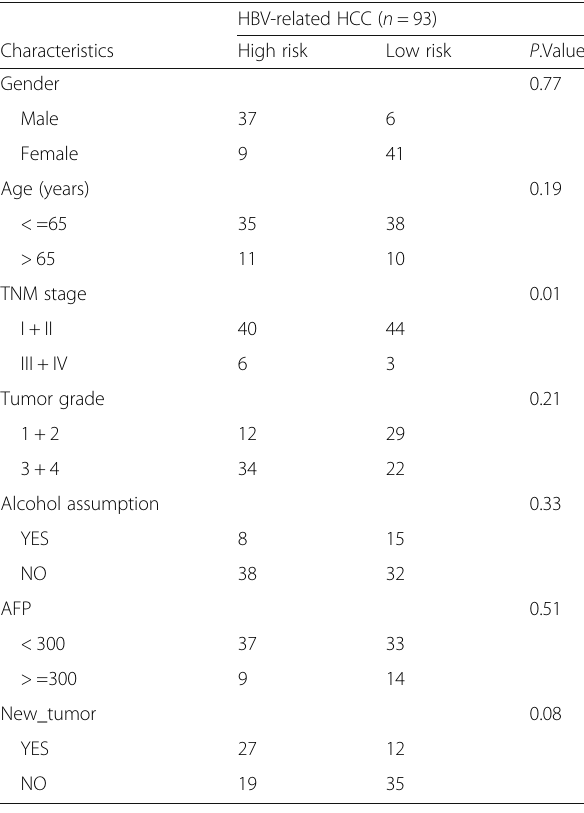
two-gene signature in HBV-related HCC in TCGA cohort